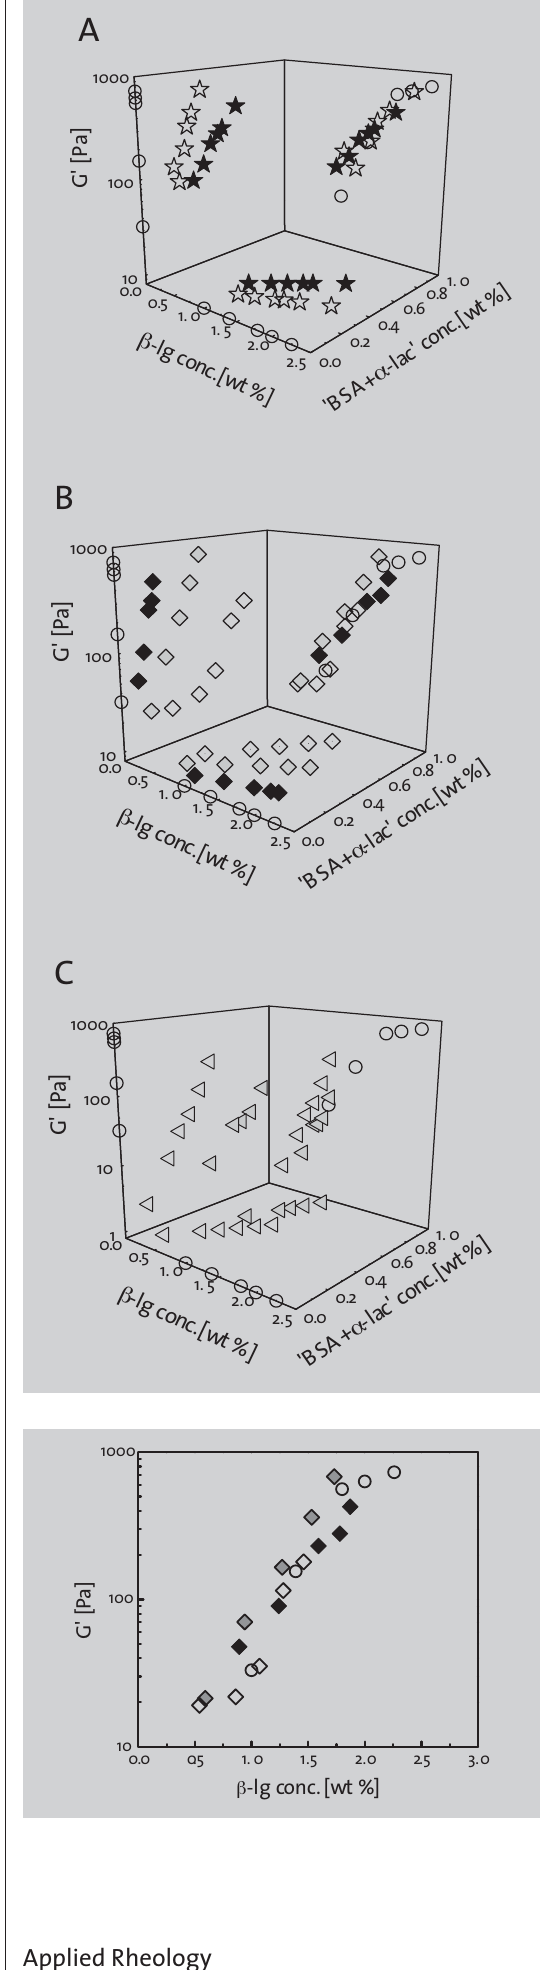
Figure 3 (above): G’ versus both the b -lg con- centration and the ‘BSA + a - lac’ concentration for sam- ples with varying whey protein compositions, shown as the projections of the data points in space on the planes. Samples were first heated at 2.5 wt % for